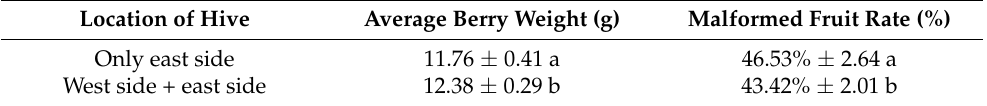
Table 7. Location impacts of two hives (bee number is 4000).